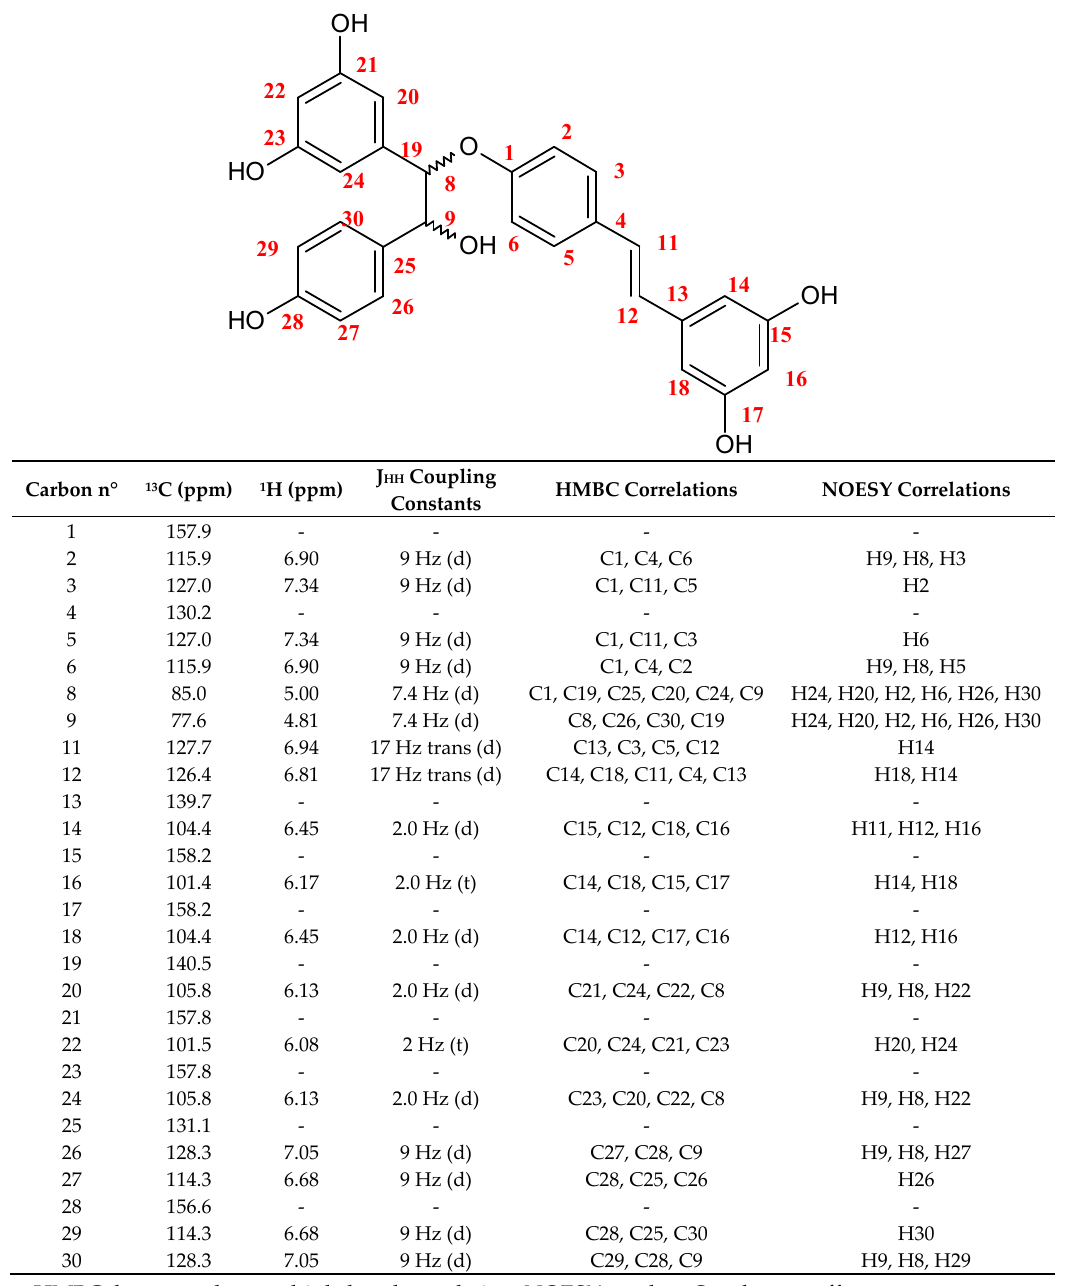
Figure 1. Chemical structure and nuclear magnetic resonance (NMR) data for labruscol ( 1 ).